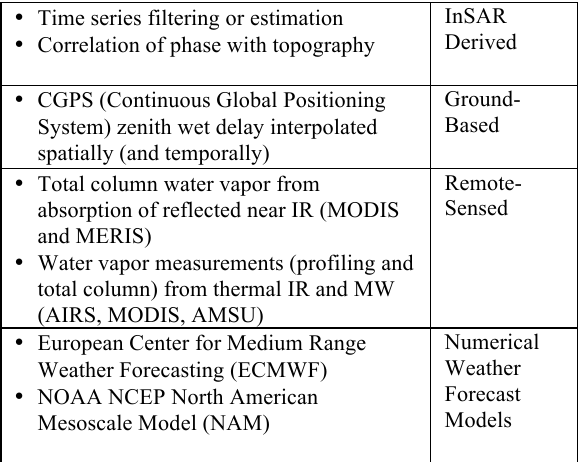
Table 3. Datasets utilized by OSCAR to derive tropospheric water vapor corrections for